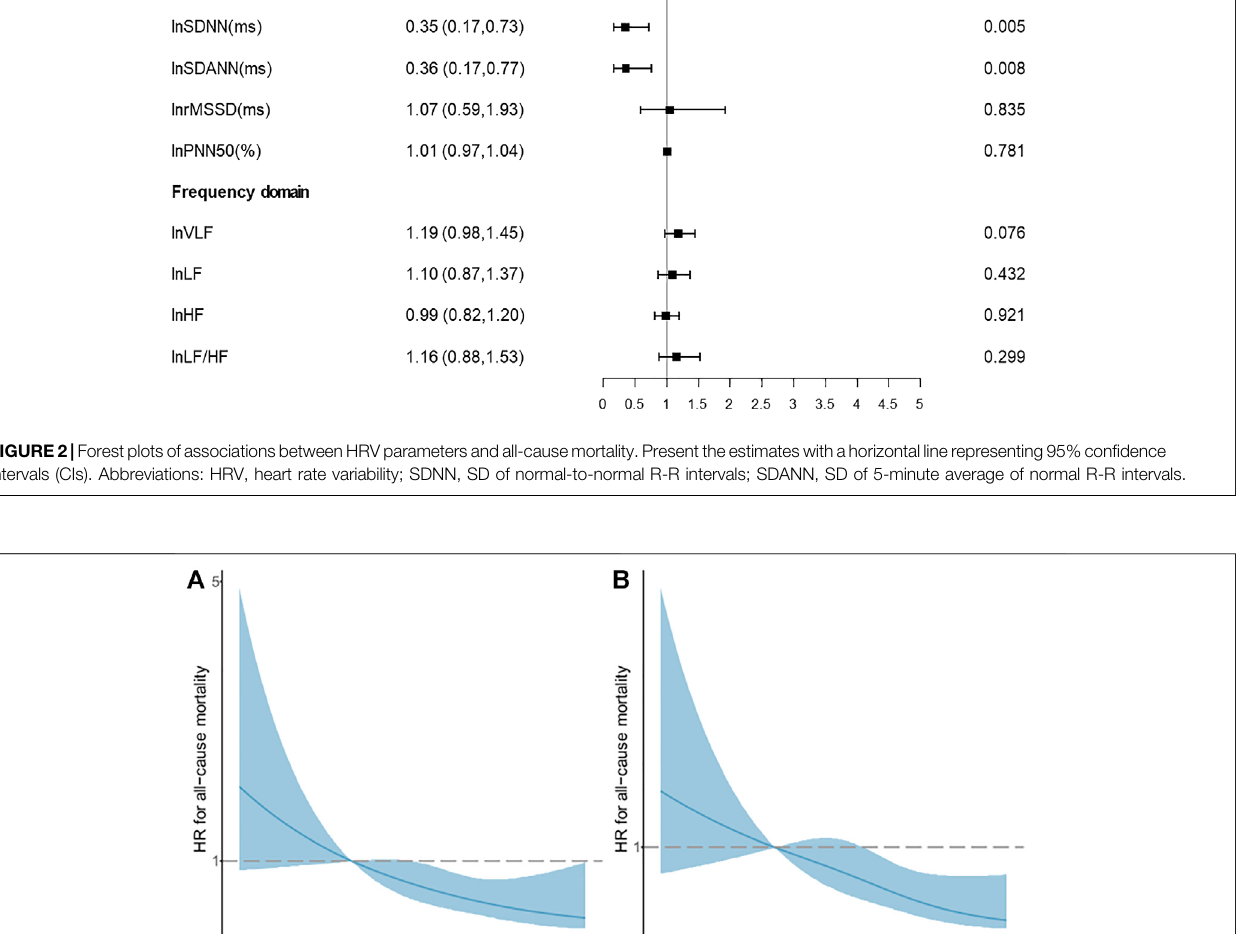
Frontiers in Genetics |